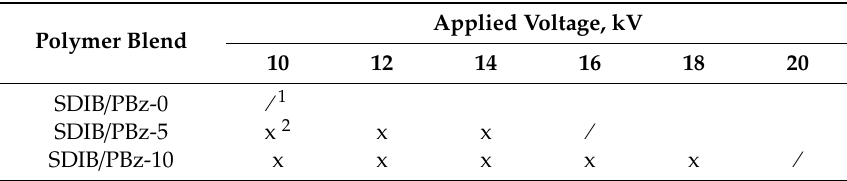
Table 1. Variation in Applied Voltage used for Electrospinning of SDIB / PBz. Polymer